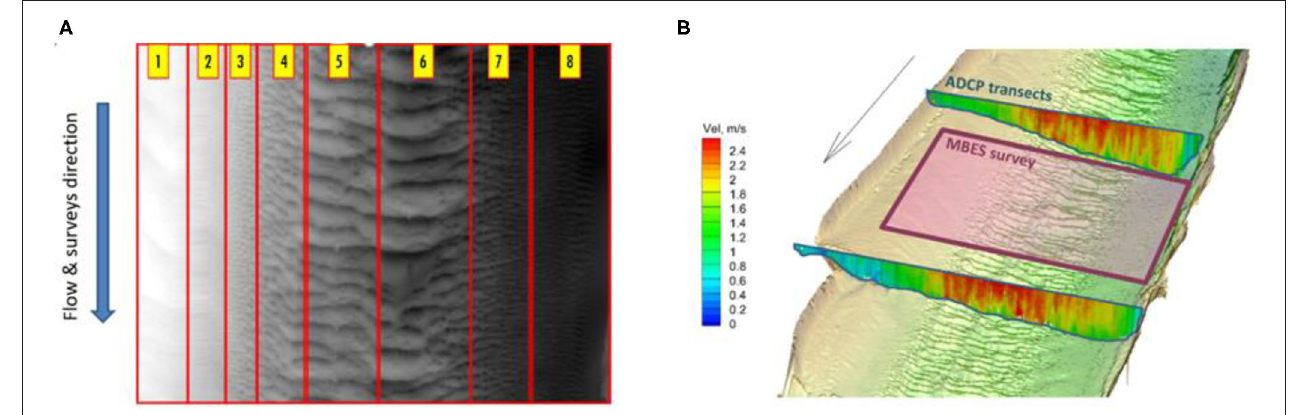
FIGURE 3 | Zoning of the MBES map with considerations of the cross-sectional distribution of the bedform characteristics: (A) bedform elevations; (B) velocity and depth distributions.